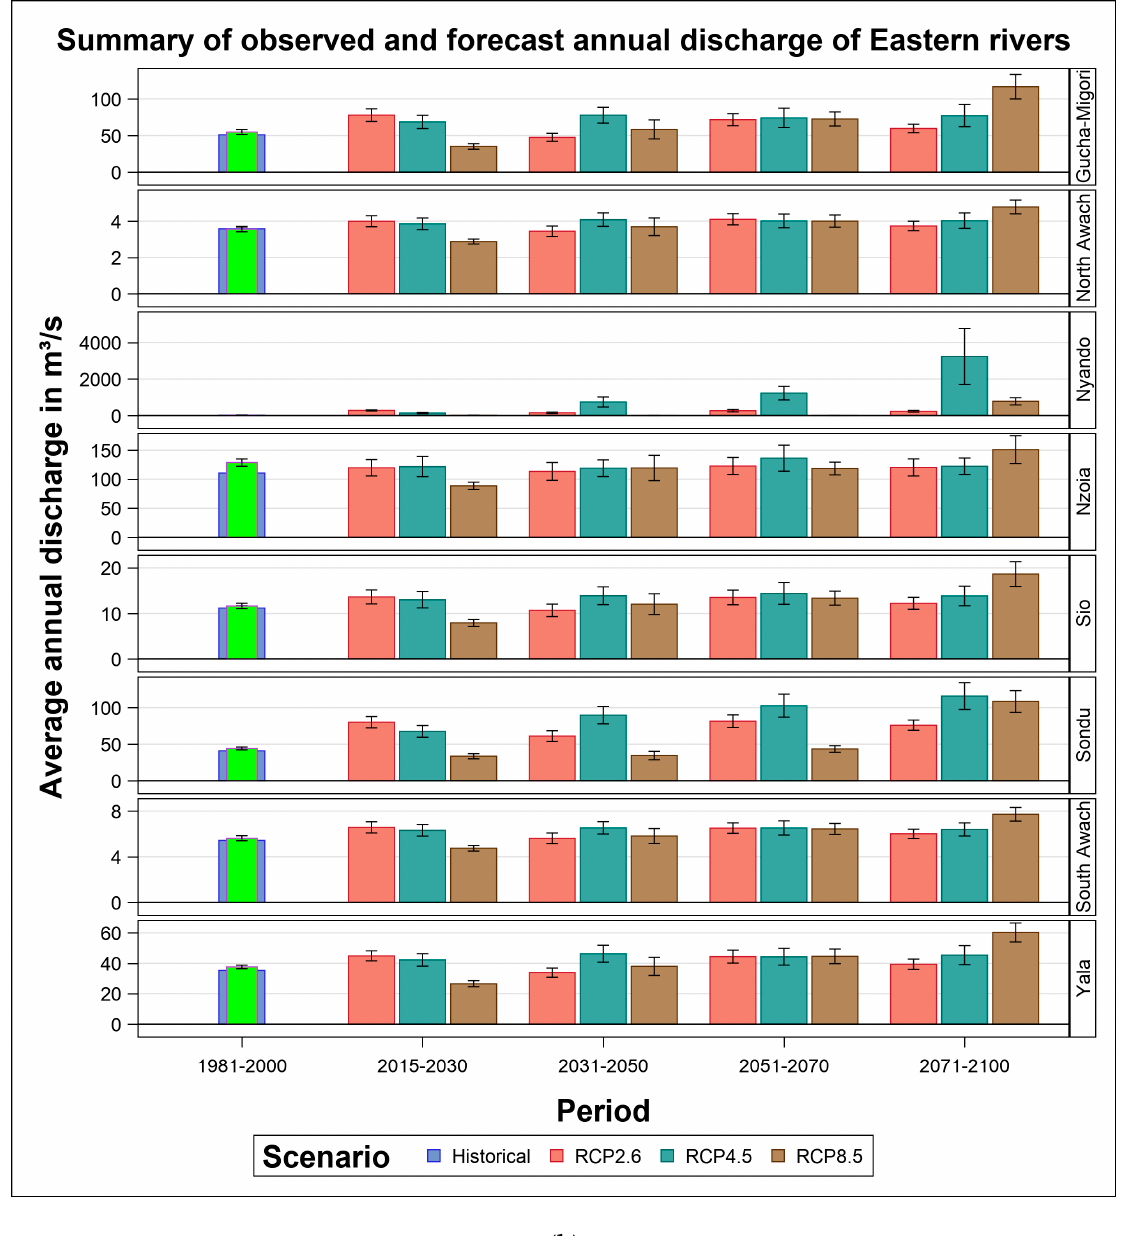
Figure 5. ( a ) Projected average annual river discharge in relation to rainfall and ( b ) summary of the observed (historical) and projected average annual discharge for rivers flowing into the eastern part of the Lake Victoria Basin for the 2030s, 2050s, and 2070s under the RCP 2.6, 4.5, and 8.5 scenarios. The bright green bar is the average of the observed historic series while the wider medium slate blue bar is the value for the historic series predicted by the fitted model.